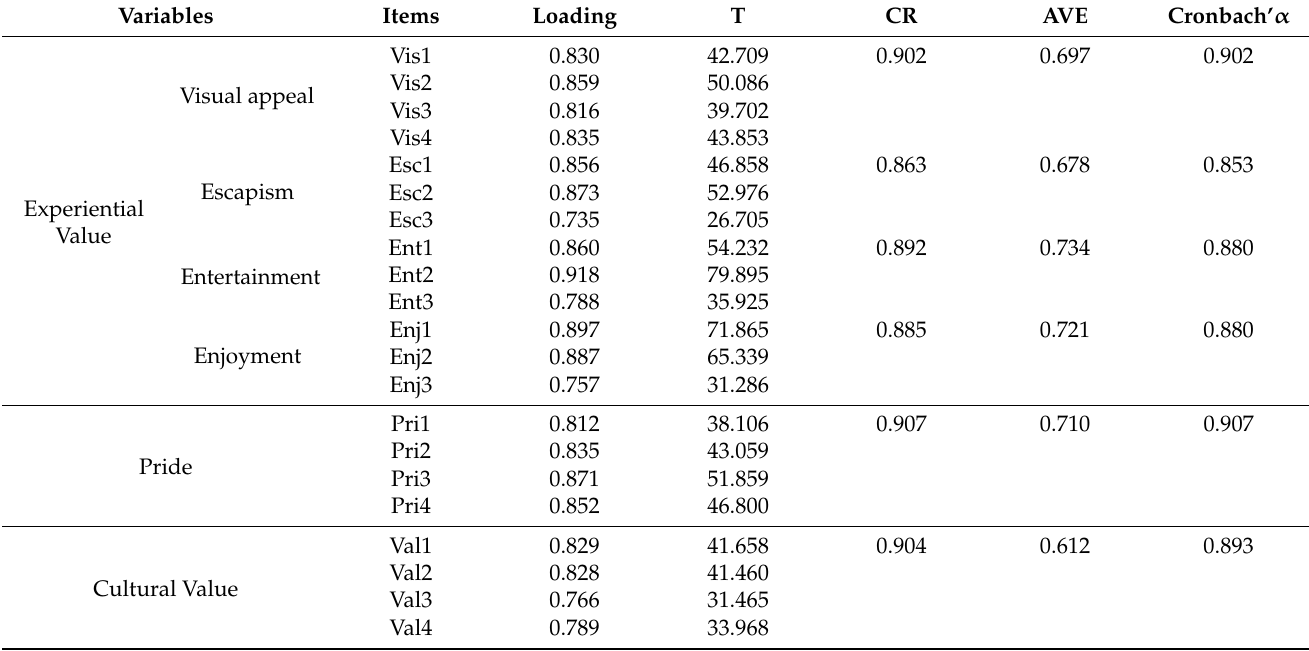
Table 3. Results of composite reliability and convergent